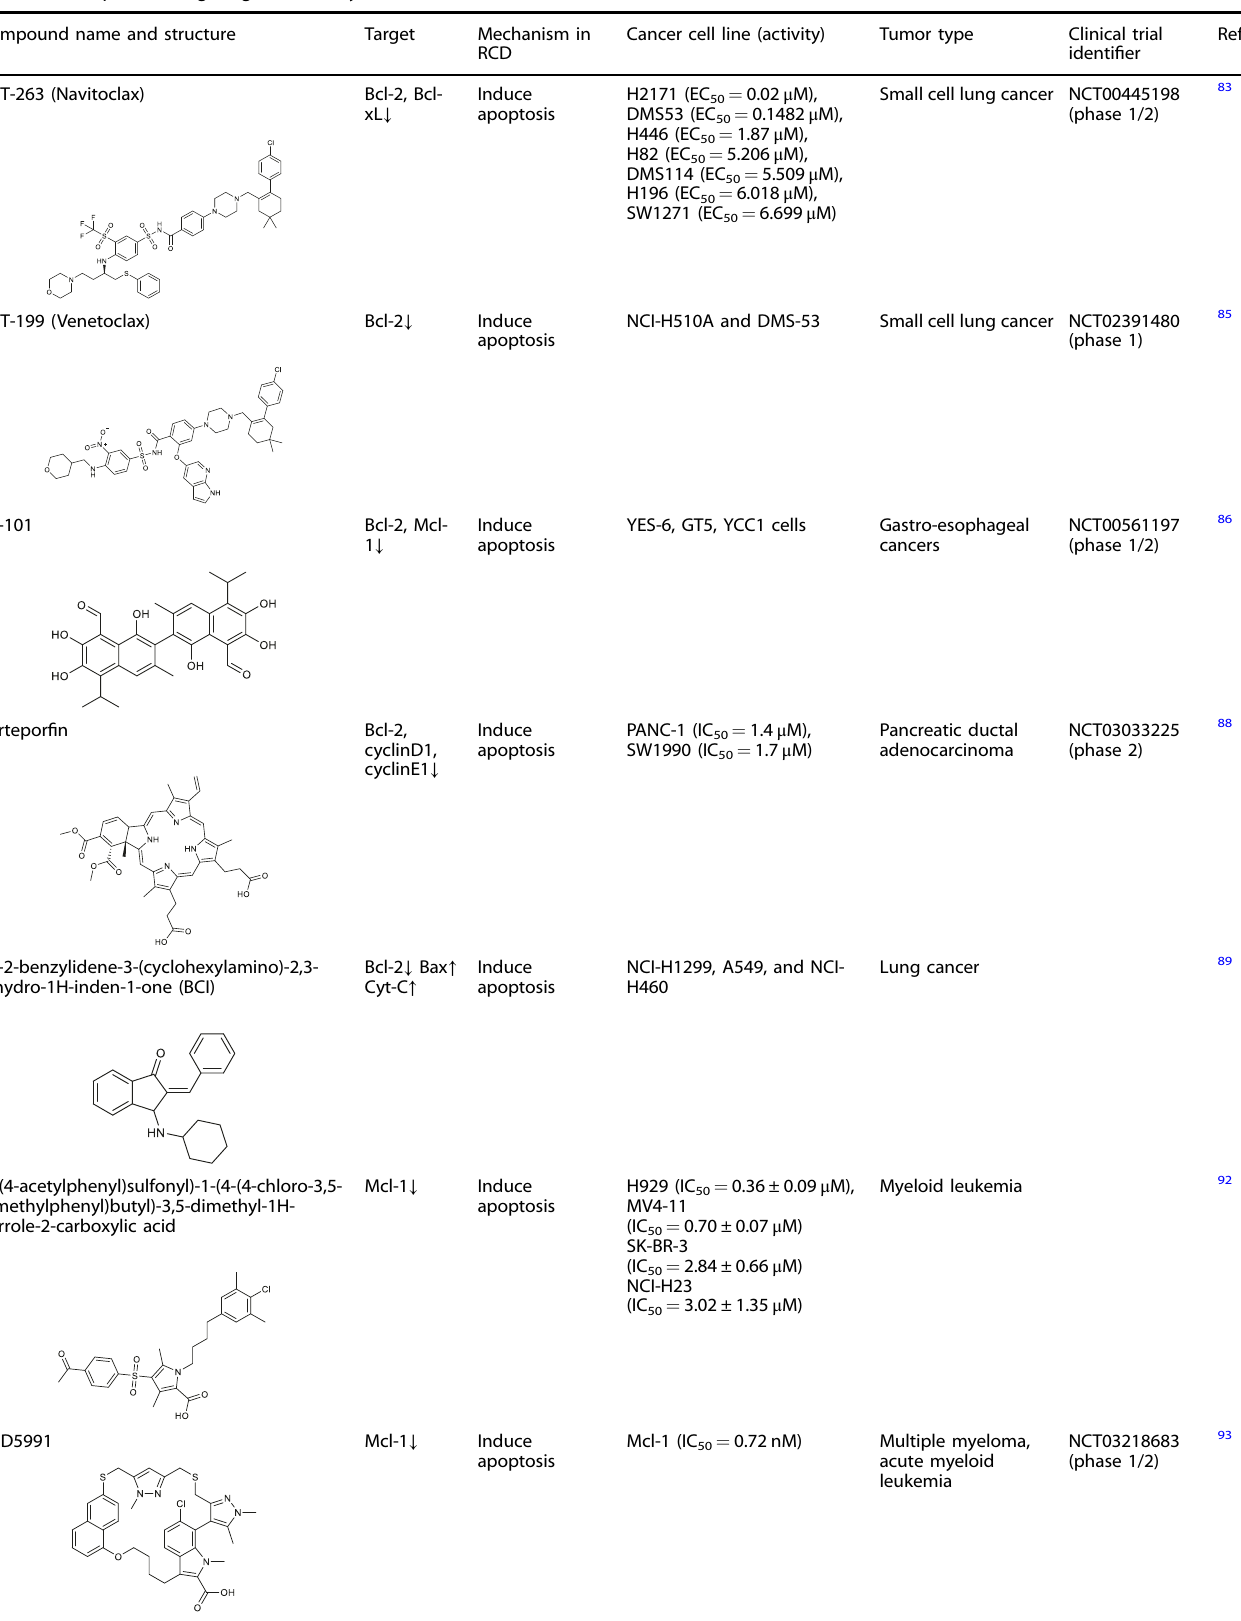
Table 2. Compounds targeting Bcl-2 family in